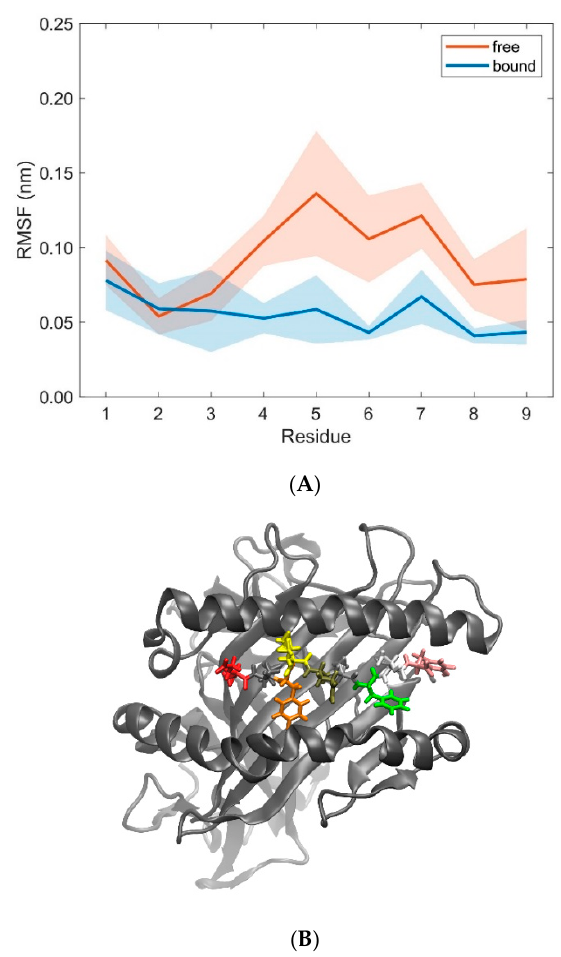
Figure 11. ( A ) RMSF-values (mean ± SD) of MHC peptide residues in free (orange) and bound (blue) states calculated from 10 pooled 40 ns MD simulations each for unbound (free) and bound states. ( B ) Cartoon representation of the 3KPS MHC binding groove showing the lateral α 1- and α 2-helices and the β -sheet (grey) together with the peptide (displayed as licorice) consisting of nine residues (position 1: Glu, red; position 9: Tyr, pink) as obtained from a snapshot of a 40 ns MD simulation of a TCR-free pMHC. The figure in panel B was produced using VMD [22] .